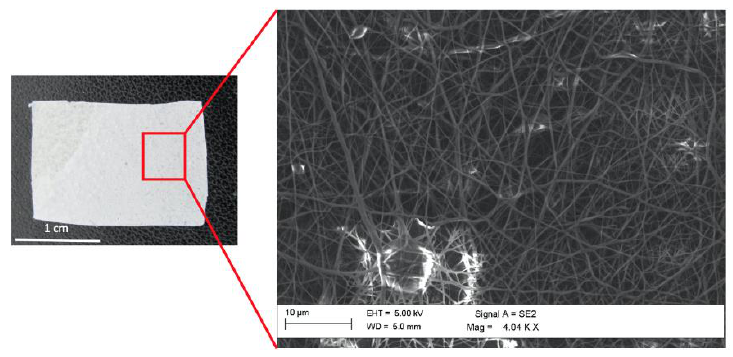
Figure 2. Electrospun fibroin sample ( left ); scanning electron microscopy (SEM) analysis ( right ) showing the fibroin fibers obtained through electrospinning technique.